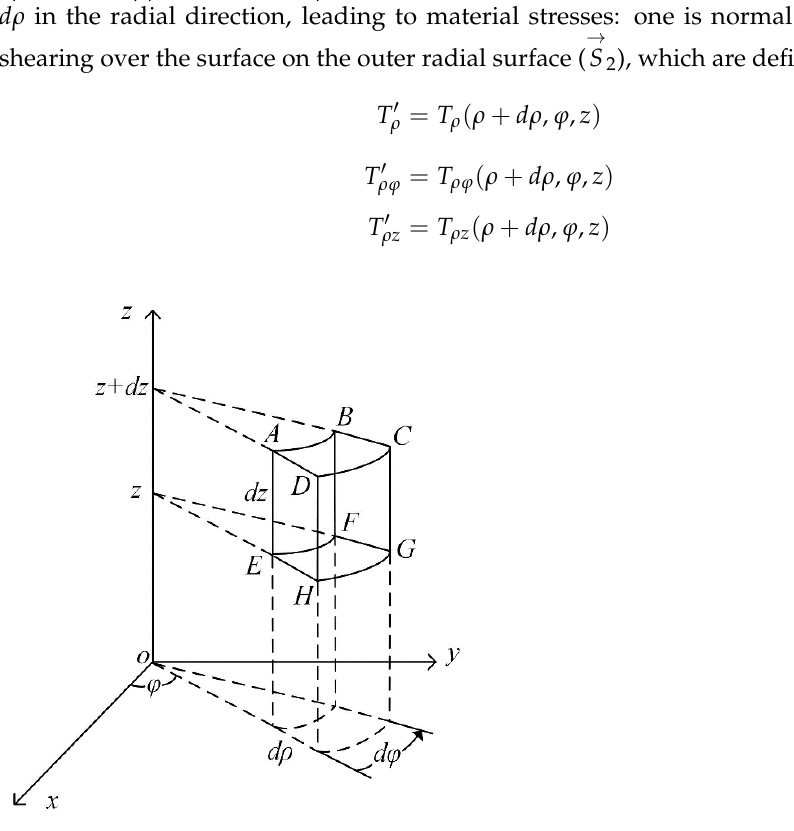
Figure 1. Schematic diagram of a microvolume element.